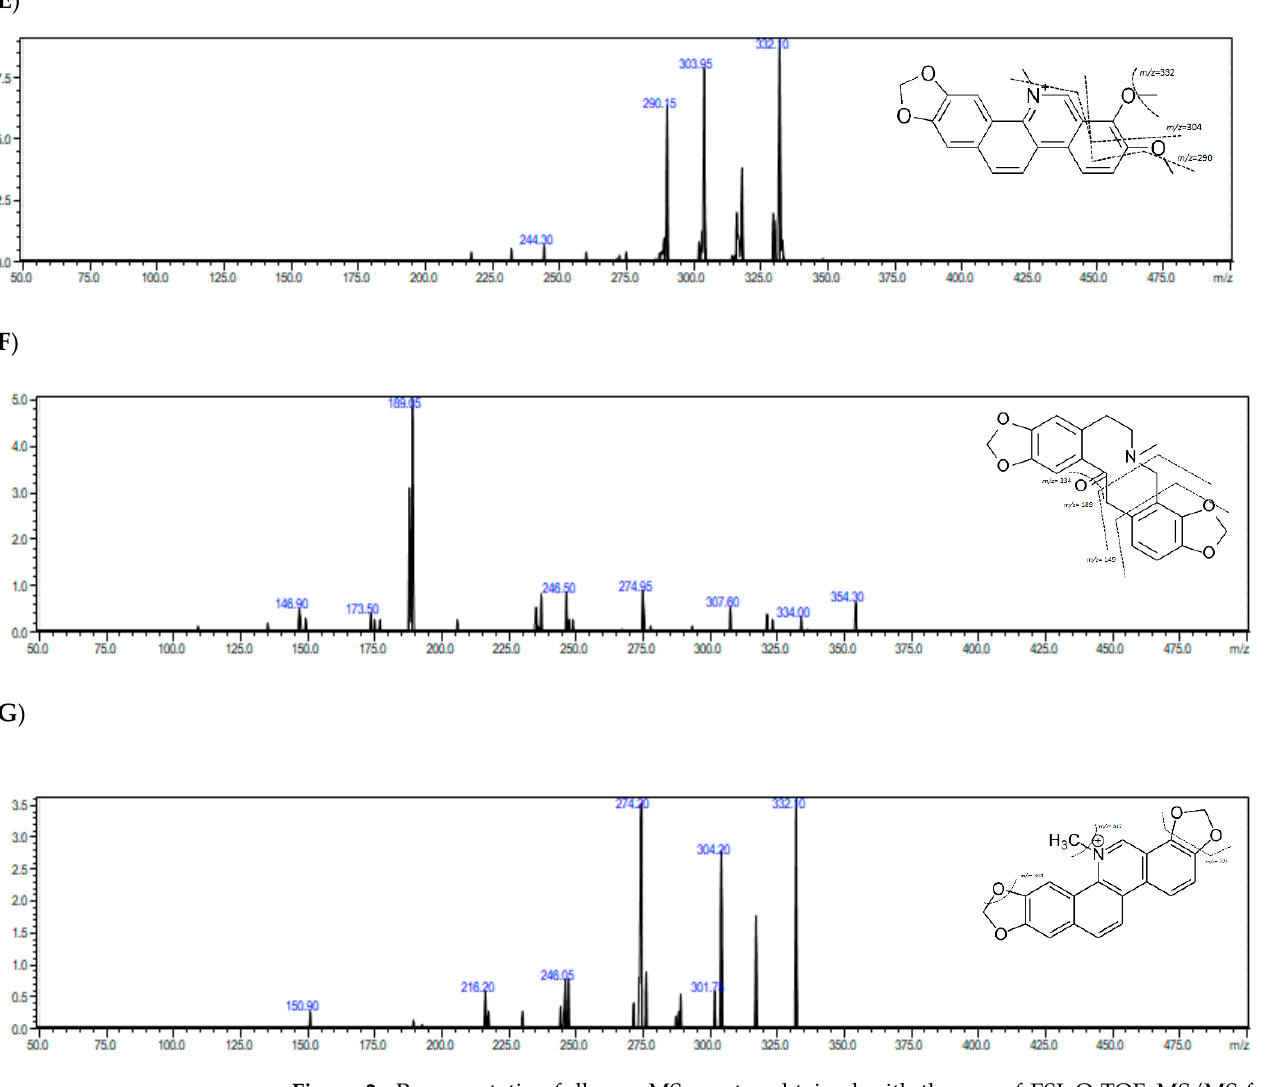
Figure 2. Representative full-scan MS spectra obtained with the use of ESI–Q-TOF–MS/MS for chelerythrine from the Macleaya cordata ’s extracts: ( A ) aerial part collected in May, ( B ) root collected in May, ( C ) aerial part collected in July, ( D ) root collected in July, as well as representative product ion MS/MS spectra obtained with the use of ESI-Q-TOF-MS/MS for chelerythrine ( E ), protopine ( F ), and sanguinarine ( G ) from the Macleaya cordata extracts.